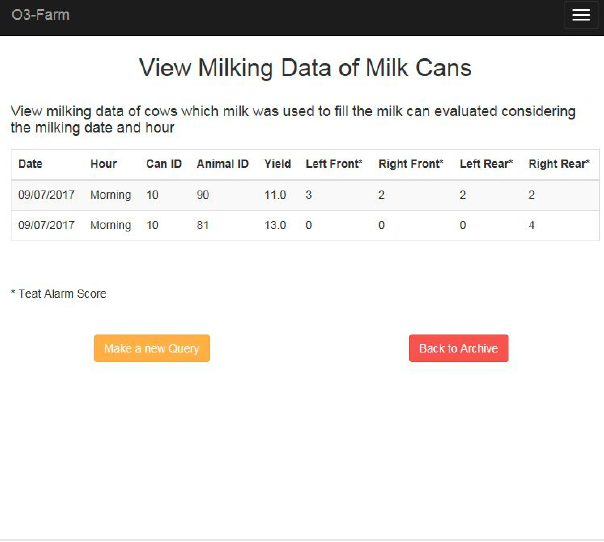
Figure 9. Form available for milkers to add milking data after a milking session. 3.3. Description of the Business Procedures Data entry of the O3-Farm application is shared between different groups of users and designed in business processes. The most frequent process has a structure like the one reported in the diagram of Figure 10. This type of business process is used when a user must store a set of data in the database. When he/she submits a set of inputs, by a dedicated web form, the process starts and a “service task” allows data submitted to be collected and recorded. After this task, the process ends.